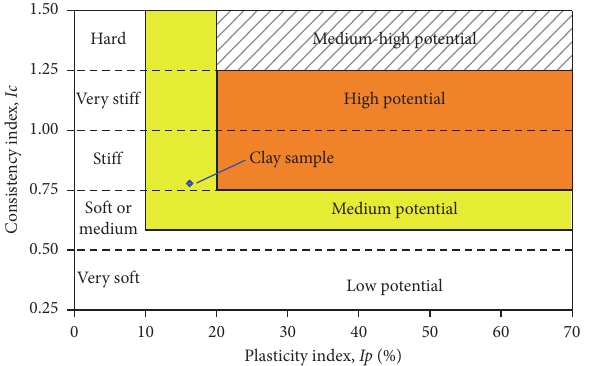
Figure 1: Modified clogging potential based on Thewes’ method [3].